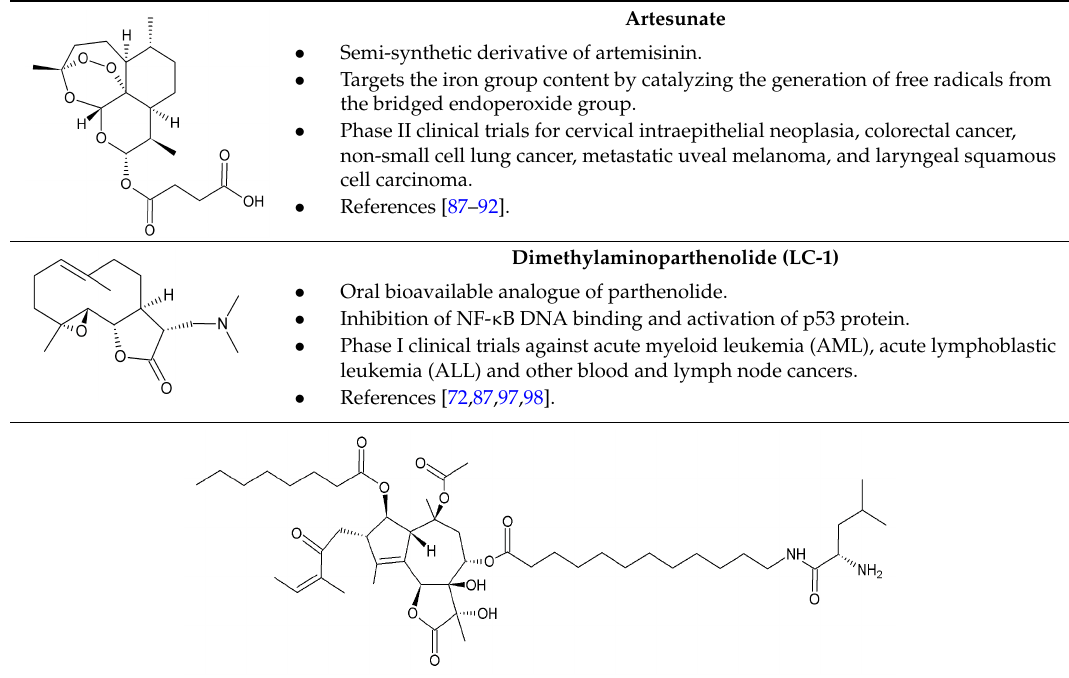
Table 2. Sesquiterpene lactones that are in clinical trials as anti-cancer drugs. The table shows the structures of the three compounds (artesunate, LC-1, and L12ADT), the sources, the mechanisms of action and references.